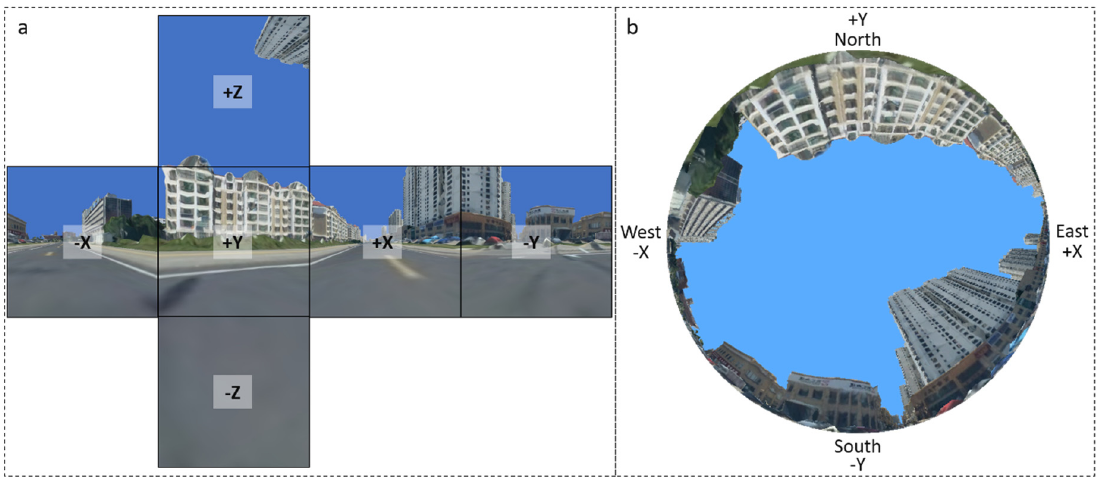
Figure 1. ( a ) Cube map and ( b ) hemispherical view at the same ground location.